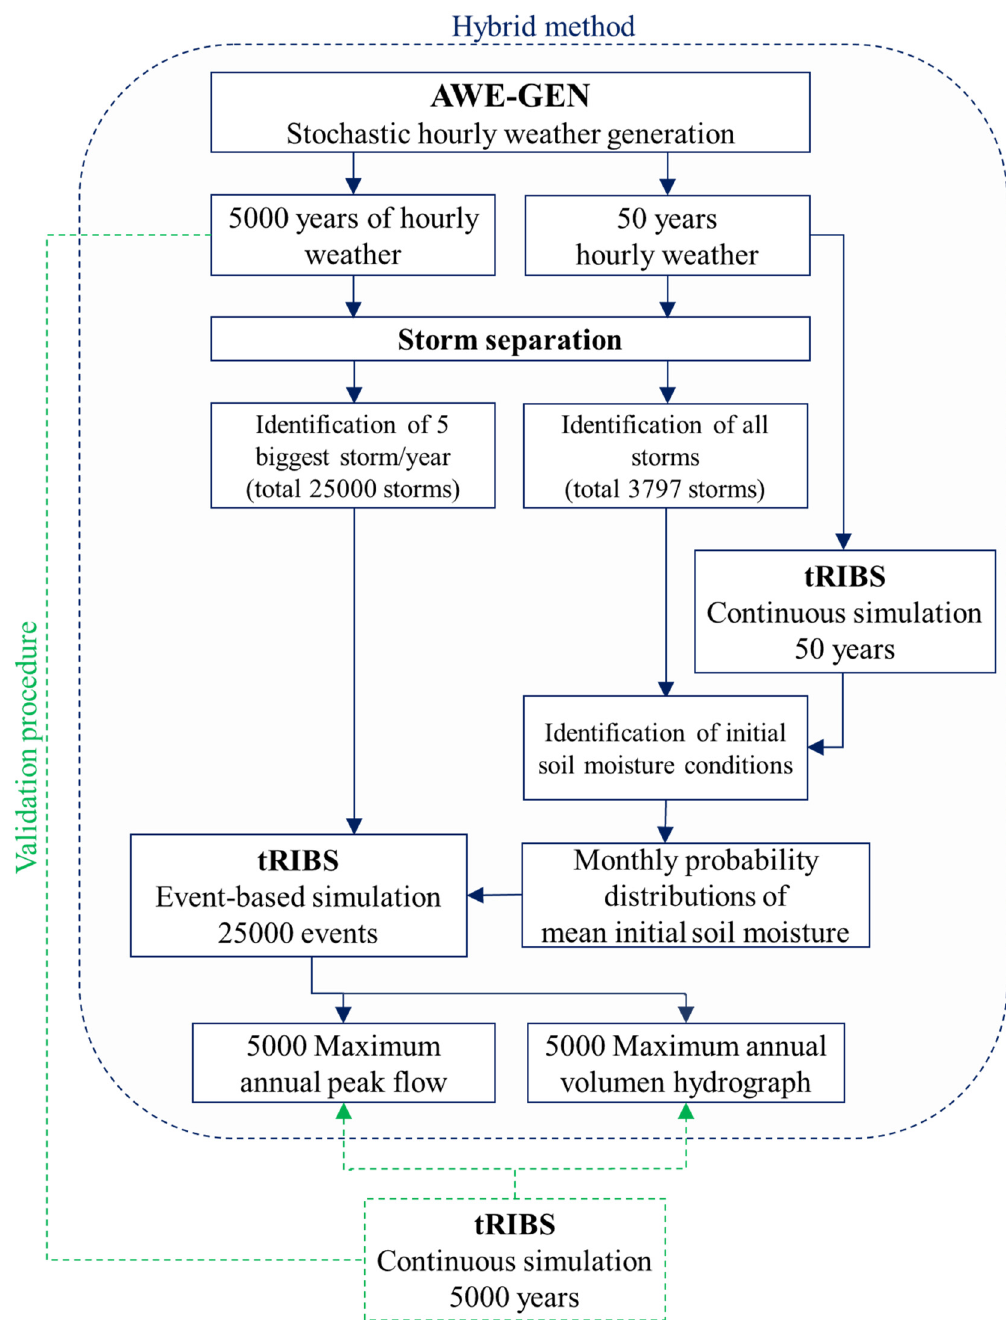
Figure 3. General scheme of the hybrid method (blue lines) and validation procedure (green lines).